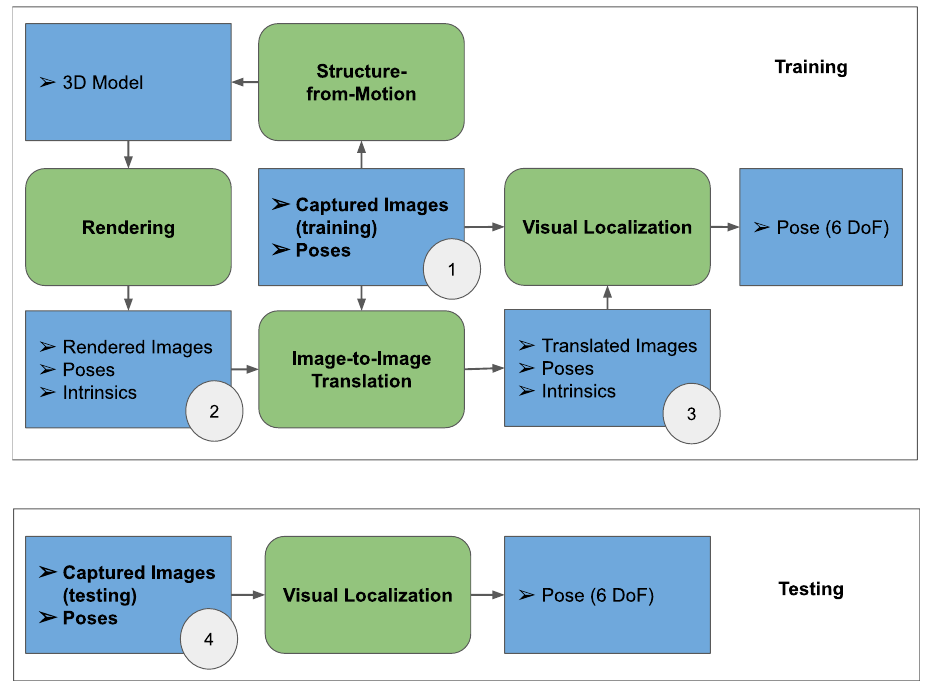
Figure 1. Workflow of translating images from a training set of captured images and training a visual localization pipeline. Captured training images 1 (cid:13) are used to create a 3D model through Structure-from-Motion (SfM). Rendered images are generated with specific poses and with camera intrinsics within this 3D model 2 (cid:13) . These rendered images and the captured images serve as input to train an image translation network. This network translates images in the rendered domain into translated images in the captured domain 3 (cid:13) . Captured 1 (cid:13) and translated 3 (cid:13) images are used to train a visual localization pipeline. Experiments are also carried out on rendered images 2 (cid:13) and on feature matching as well as image retrieval. Testing is carried out on the captured images from a test sequence 4 (cid:13) . None of the test images is utilized in the prior training process. For comparison purpose each experiment is carried out on the captured images, the rendered images and the translated images in Section 4. Given data is highlighted in bold